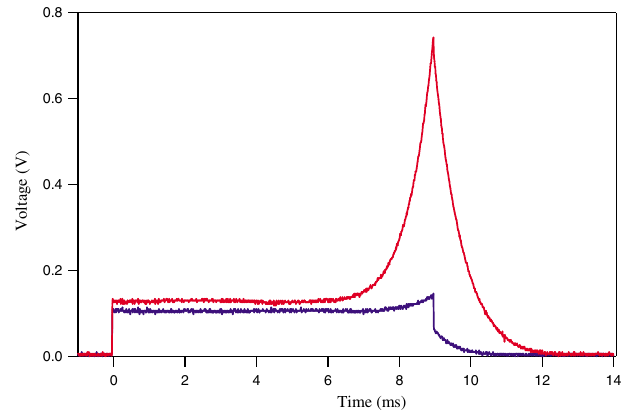
FIG. 4. (Color) HOM voltage measured from the unstable cavity for 9 ms long macropulses with 4.5 mA of average current (blue) and 5.0 mA of average current (red).